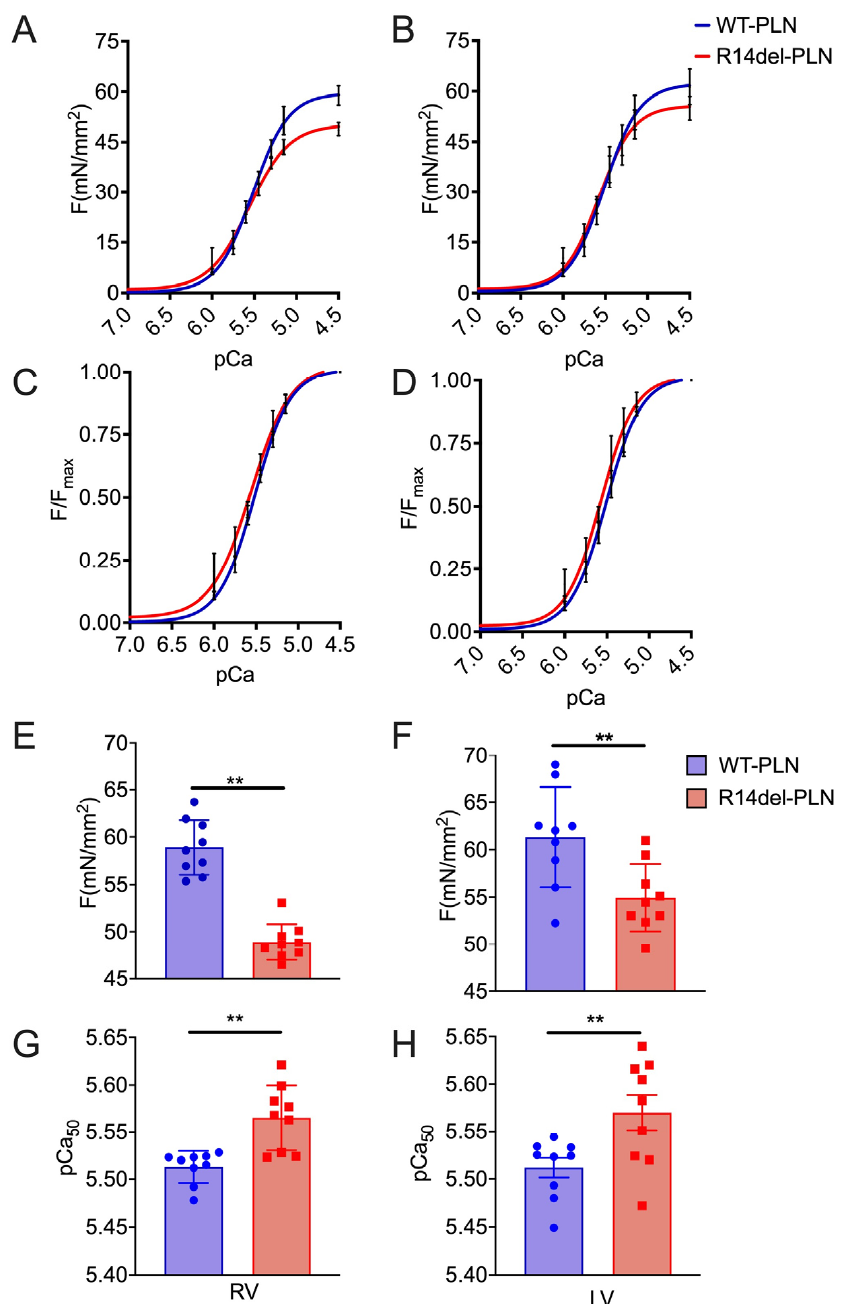
Figure 1. Force–pCa relationship in skinned cardiomyocytes. ( A , E ) Skinned RV myocytes from R14del- PLN hearts (48.9 ± 0.63 mN/mm 2 , n = 9 cells/3 hearts) showed a significant decrease in maximal force development compared with WT- PLN RV myocytes (58.92 ± 0.96 mN/mm 2 , n = 9 cells/3 hearts). ( B , F ) Similarly, LV skinned myocytes from R14del (54.94 ± 1.18 mN/mm 2 , n = 9 cells/3 hearts) showed a significant decrease in maximal force development, compared with WT- PLN LV skinned myocytes (61.34 ± 1.75 mN/mm 2 , n = 9 cells/3 hearts). Calcium sensitivity of force development, expressed as pCa 50 , was significantly increased in both RV ( C , G ) and LV ( D , H ) R14del myocytes compared to WT- PLN cardiomyocytes. mN = millinewtons. Data are expressed as mean ± SD, and statistical analyses were performed with Student’s unpaired t -test. ** p ≤ 0.01 vs. WT- PLN .